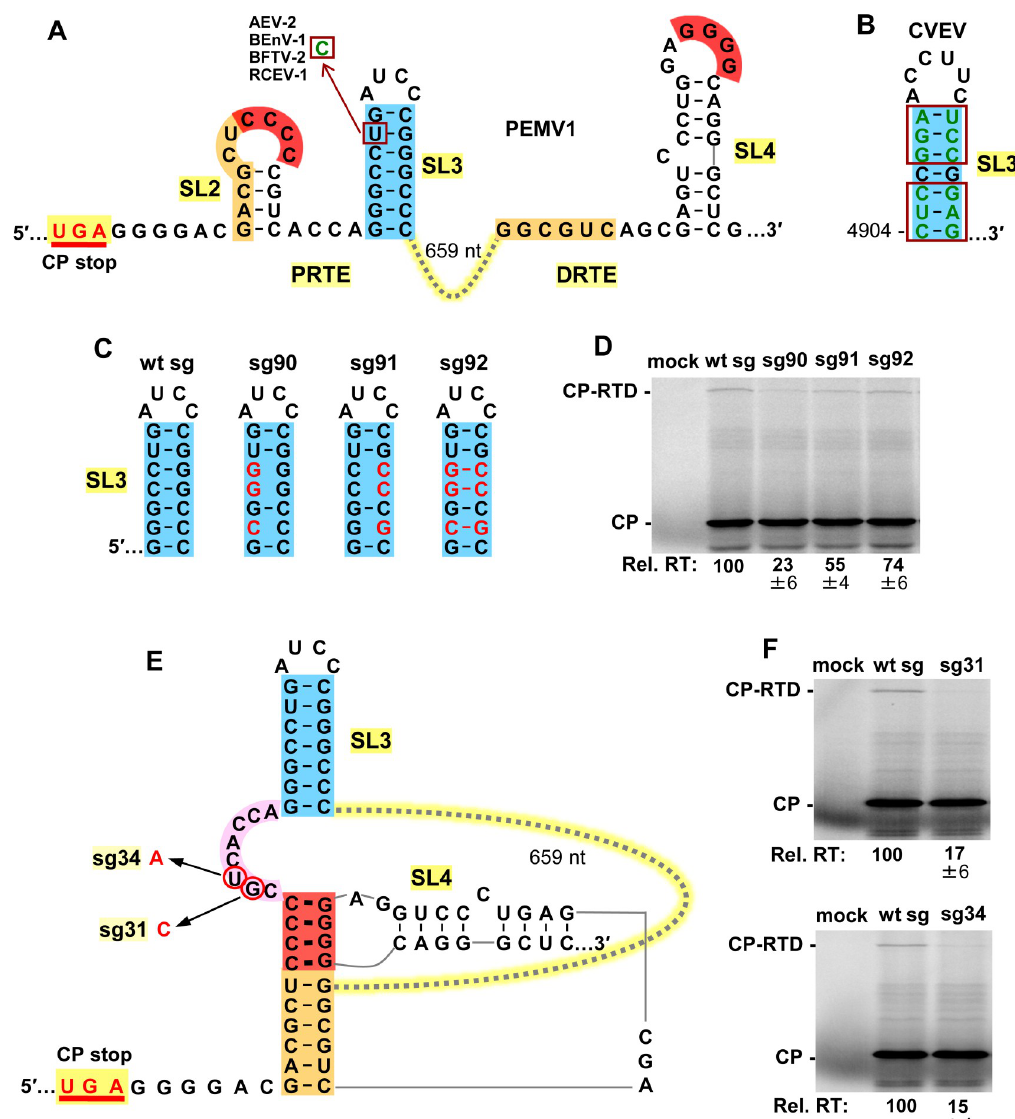
Fig 5. Assessing the local SL3 (blue) in the PRTE. (A) RNA secondary structures of PRTE and DRTE in PEMV1. A nucleotide mono-variation (U to C) in the SL3 of four enamoviruses that maintains base pairing is shown (boxed). Alfalfa enamovirus-2 (AEV-2, KY985463.1), bean enamovirus-1 (BEnV-1, MZ361924), birdsfoot trefoil virus-2 (BFTV-2, NC_048296) and red clover enamovirus-1 (RCEV-1, MN412742). (B) SL3 of citrus vein enation virus (CVEV, NC_021564). Covariations in the SL3 stem that maintain pairing are boxed. (C) Compensatory mutations introduced into SL3, with substitutions depicted in red. (D) Results of in vitro translation reactions for the sg mRNAs shown in panel C. Averaged Rel. RT levels ( ± SE) calculated from three independent trials are shown below each lane. (E) Proposed RNA secondary structure when the red and orange long-distance interactions between the PRTE and DRTE occur. The linker sequence between red and blue helices is highlighted in pink, with corresponding substitutions in mutant sg mRNAs circled and indicated in red. (F) Results of in vitro translation reactions for mutant sg mRNAs shown in panel E. Averaged Rel. RT levels ( ± SE) calculated from three independent trials are shown below each